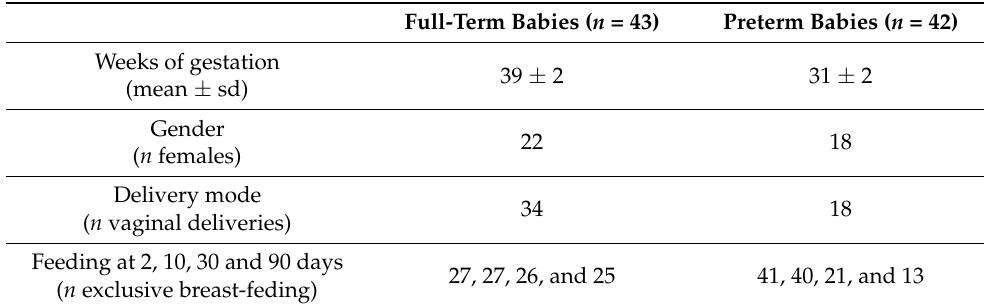
Table 1. Basal characteristics of the infant groups included in this